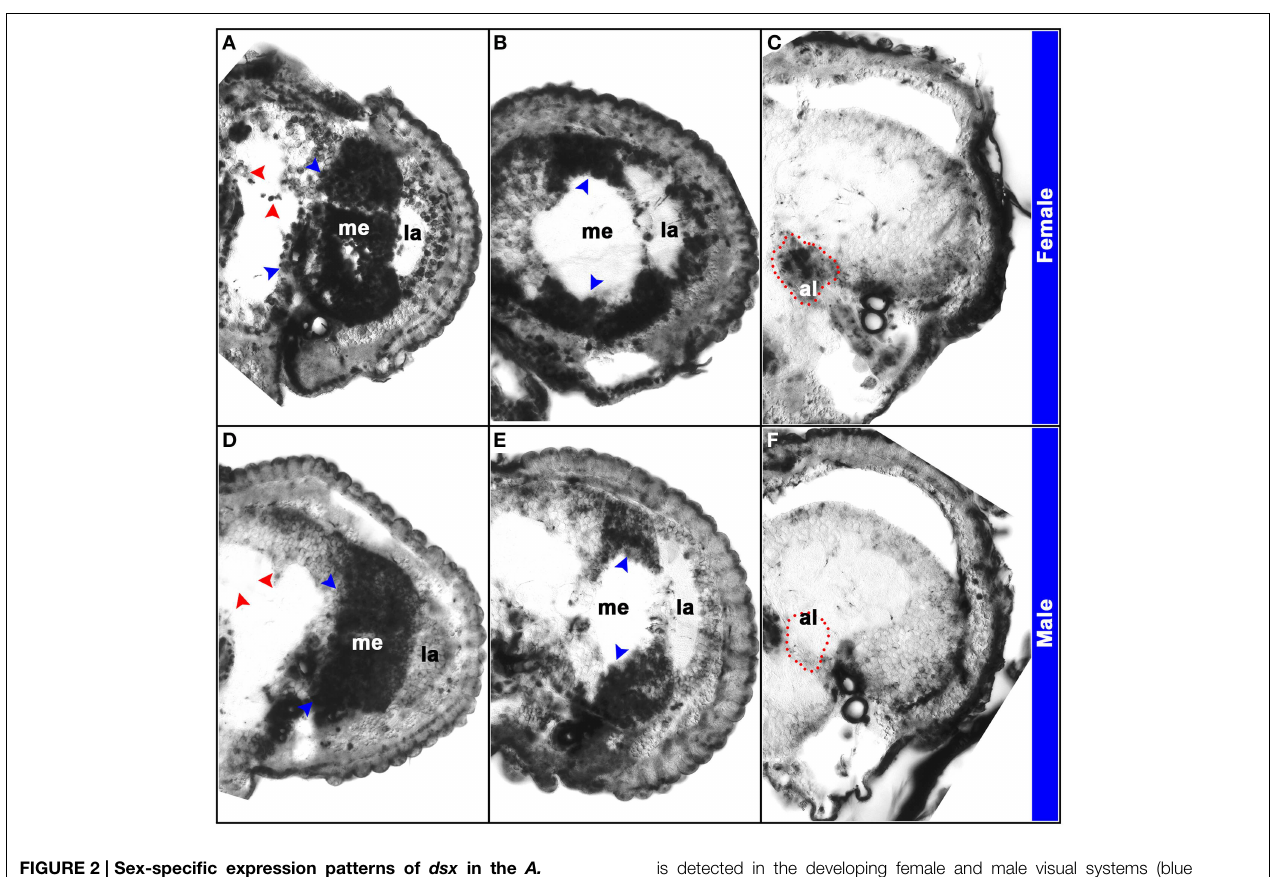
FIGURE 2 | Sex-specific expression patterns of dsx in the A. aegypti pupal brain. Expression of dsx was analyzed through in situ hybridization experiments performed on paraffin sections of female (A–C) and male (D–F) heads. Twelve micron sections through different portions of the brain revealed the antennal lobe (al), lamina (la), and medulla (me) in brain hemisegments oriented dorsal upward (A–F) . Expression of dsx